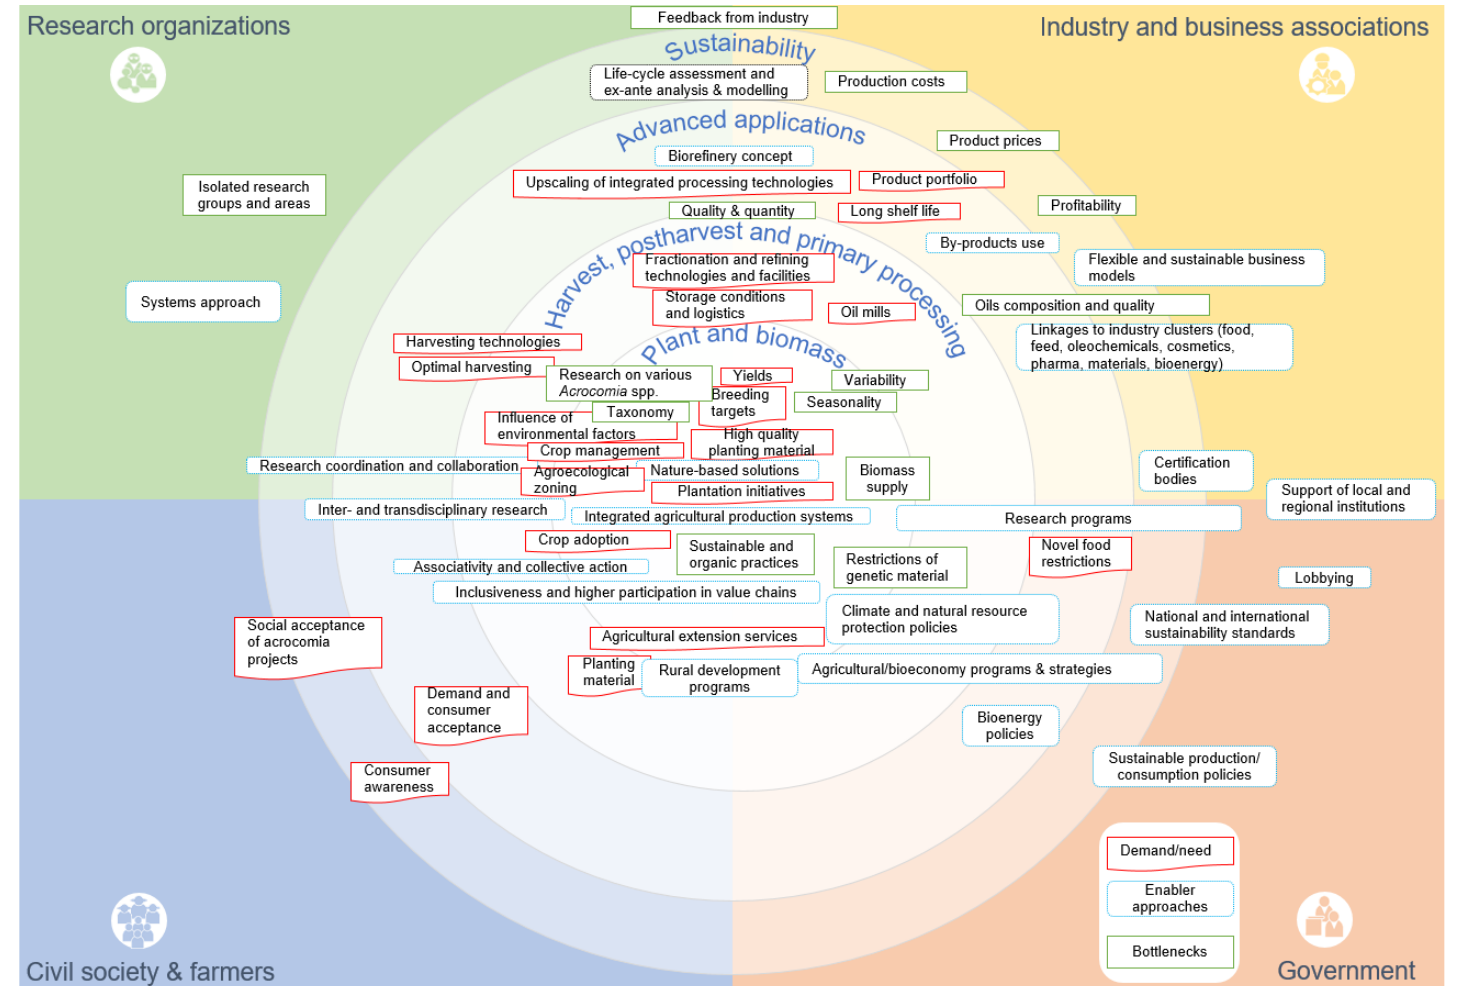
Figure 3. Priorities for the development of acrocomia value webs; results from four actor groups of the multi-actor workshop. The green, yellow, blue and orange squares represent the actor groups, i.e., research organizations, industry and business associations, civil society and farmers, and government, respectively, while the concentric circles represent value web areas.